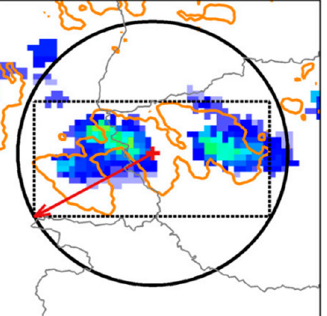
Figure 2. Matching of precipitation to CS. The orange contour represents the region with an infrared brightness temperature of 240 K, and the red cross marks the centroid of the CS. The red arrow (radius) is the maximum distance from the centroid to the four apexes of the bounding box (black dashed rectangle). A circular search range (bold black circle) can then be drawn to find the associated rain (shading) within a CS (adapted from [44]).